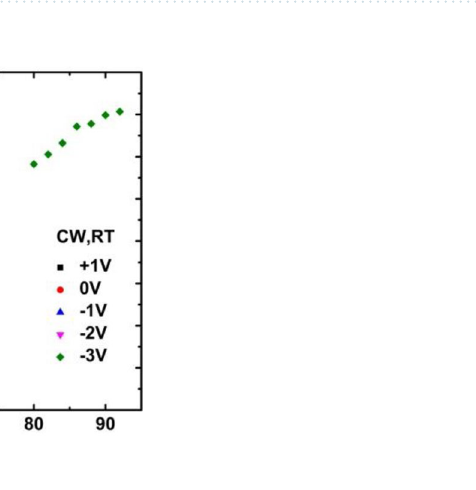
Figure 8. Peak net modal gain versus gain section current under t + 1 V, 0 V, − 1 V, − 2 V, and − 3 V, respectively.